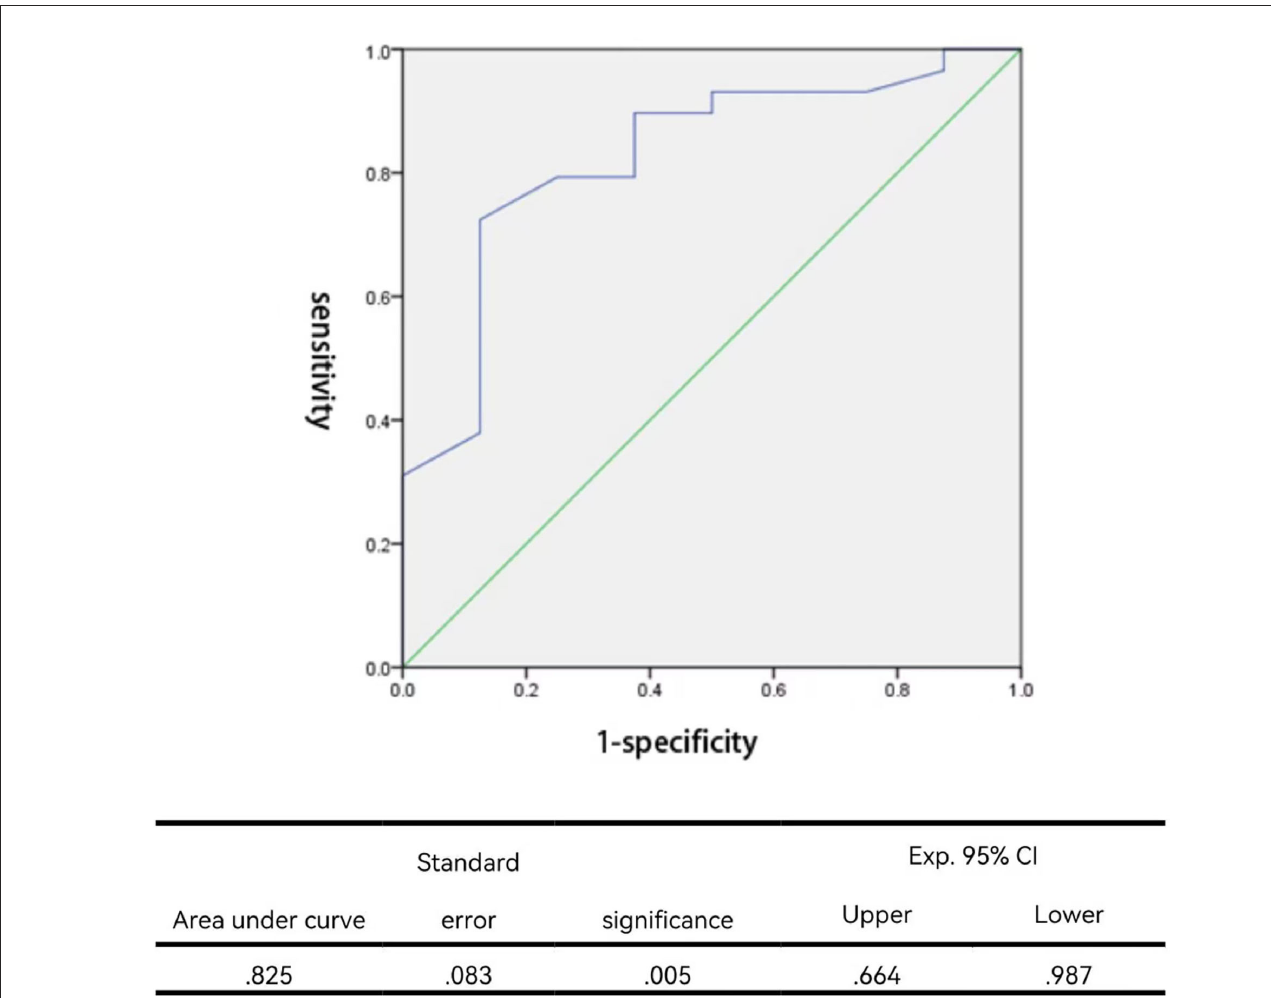
FIGURE1 Receiver operating characteristic curve for the balloon/waist ratio to predict angioplastic